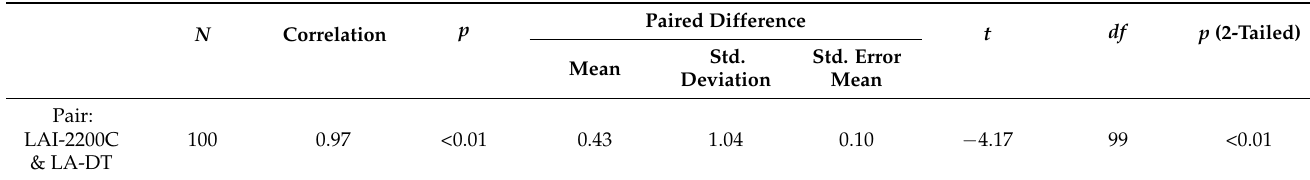
Table 3. Paired samples t -test of LA of LAI-2200C and LA-DT for 100 individual rapeseeds.